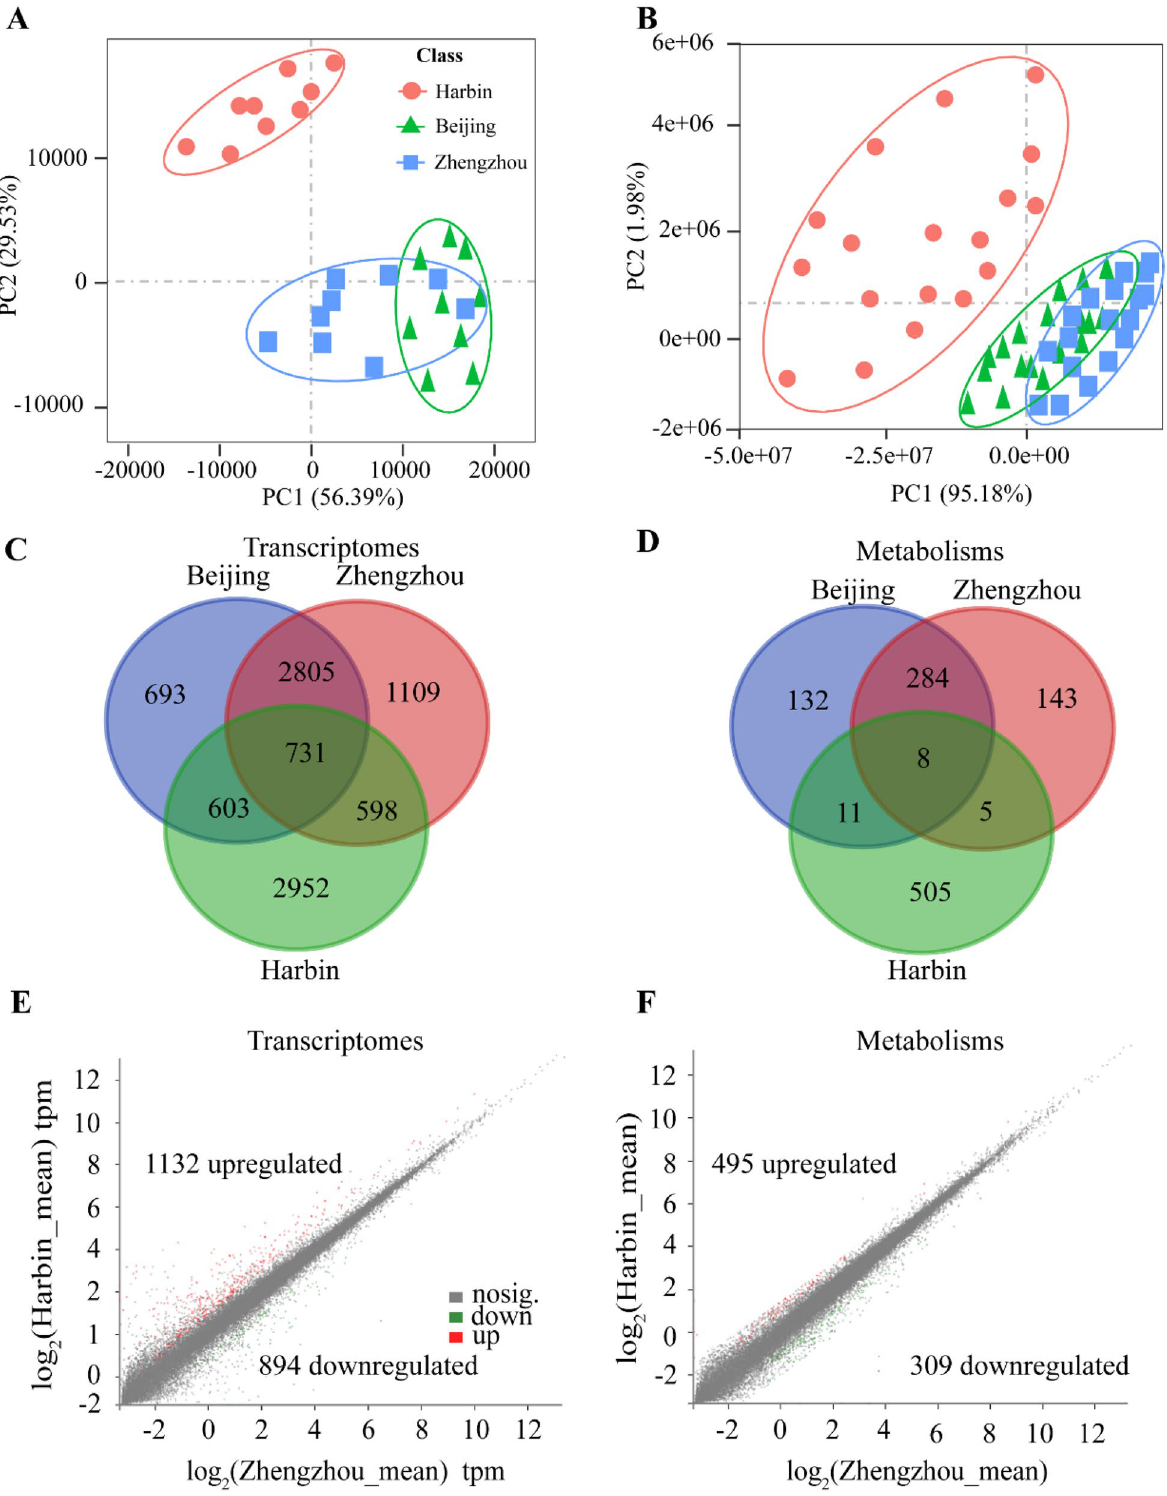
Figure 6. Principal component analysis on different experimental sites for GM-ZD958 across two different transgenic event lines (event-2.4 and 3.5) and non-GM ZD958 (CK). ( A ) Transcriptomes analysis on different experimental sites, i.e., Beijing (E116.3°, N39.7°), Harbin (E125.4°, N44.1°), and Zhengzhou (E113.6°, N34.7°) of China, across different transgenic events and CK; n = 9. ( B ) Metabolomics analysis on different experimental sites across different transgenic events and CK. n = 18. ( C , D ), Effects of different growing environments on differentially abundant genes or metabolites. ( E , F ), Comparison on down-/up-regulation of genes or metabolites between Zhengzhou and